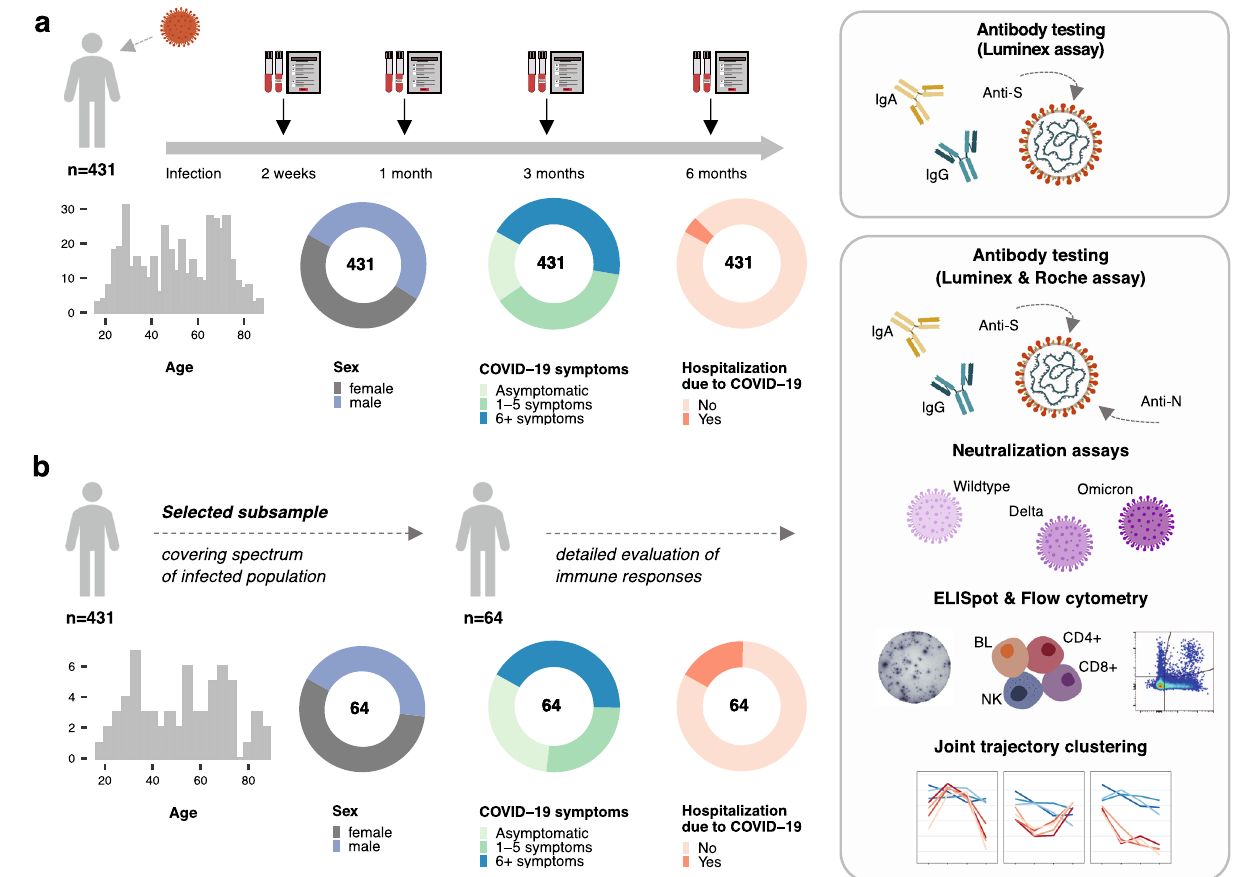
Fig. 1 | Study design and population characteristics. a Study design including follow-up timepoints, evaluated immune responses and clinical characteristics of the overall study population (total n =431). b Evaluated immune responses and